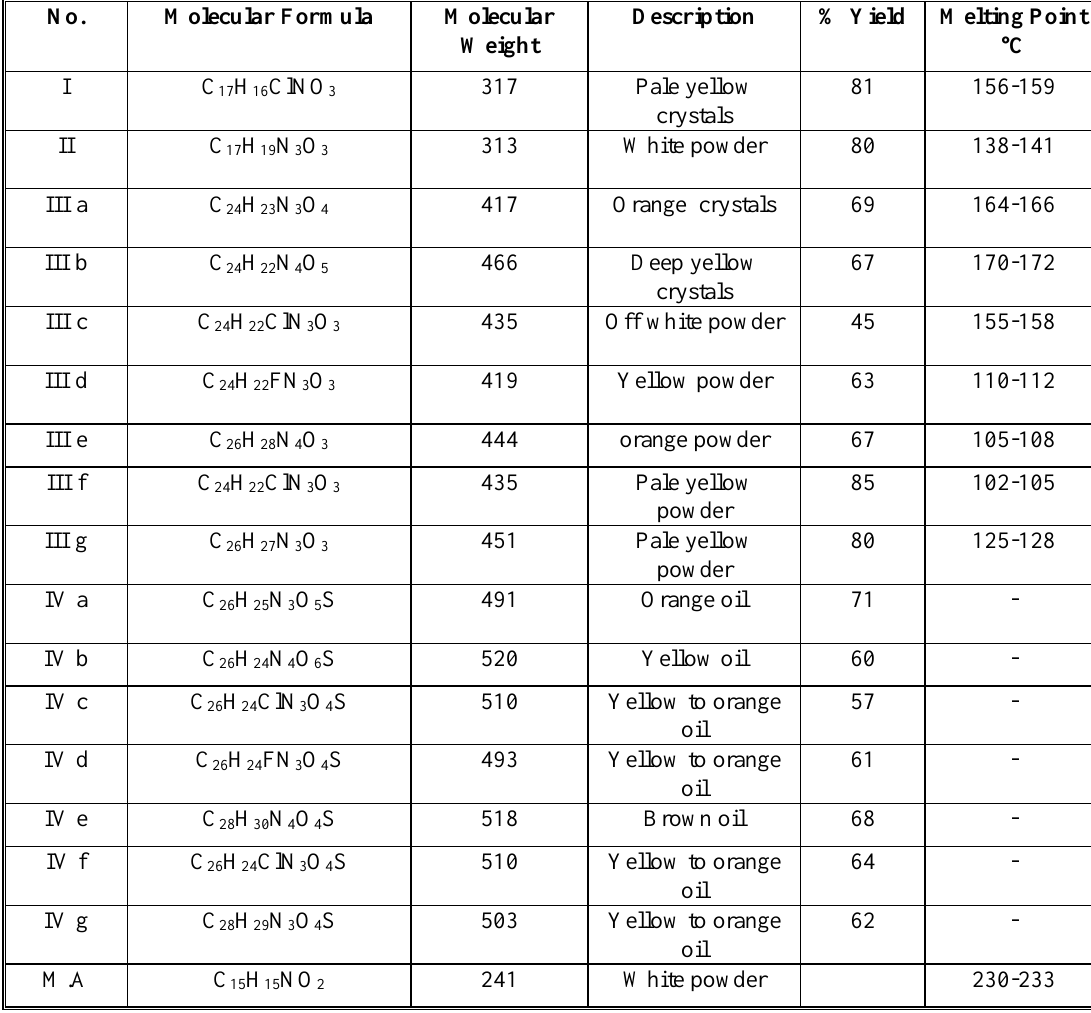
Table (2) The characterization and physical parameters of the target compounds and their